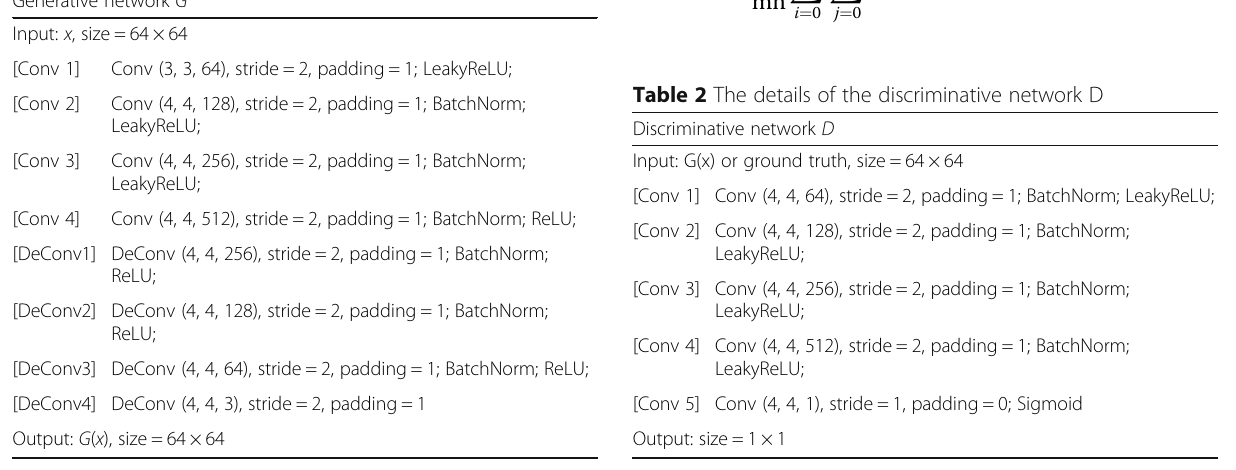
Table 1 The details of the generative network G Generative network G